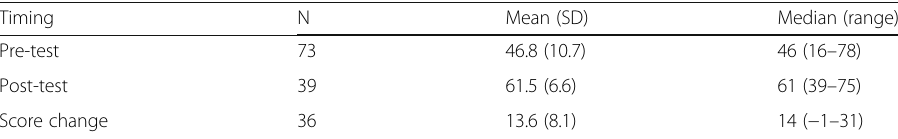
Table 4 Total student confidence scores at pre- and post-test